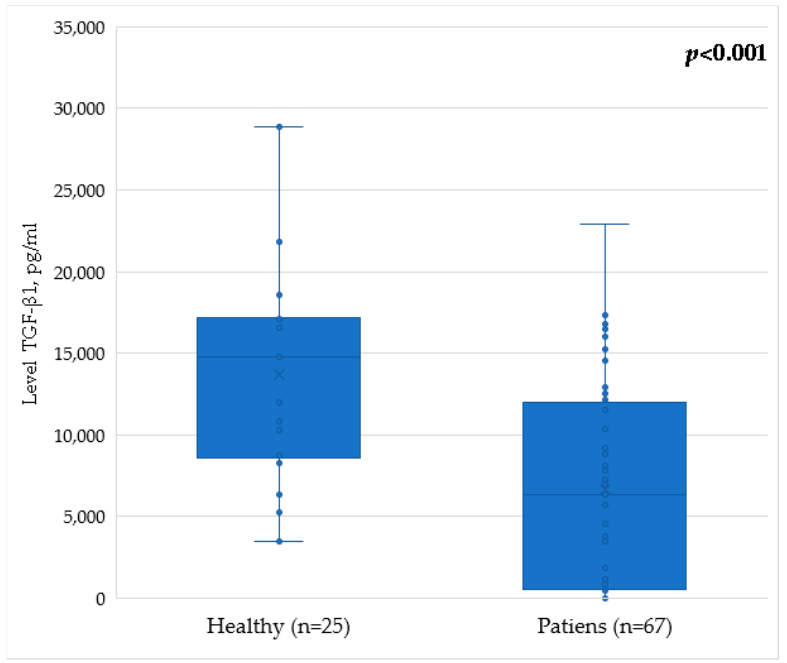
Figure 2. Level of TGF- β 1 in the serum of patients after breast cancer treatment and of healthy volunteers.